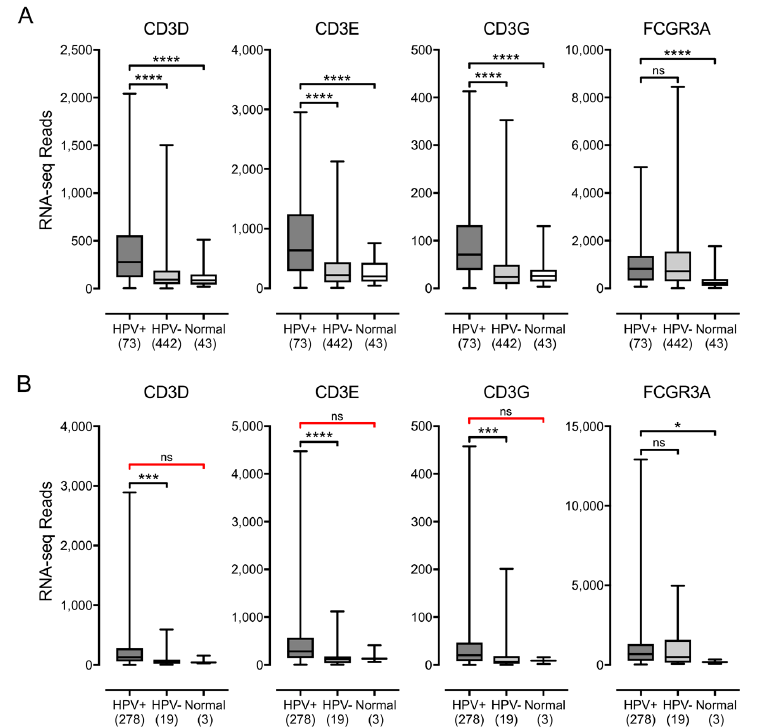
Figure 5. Detection of tumor infiltrating T-cells and NK-cells in head & neck and cervical carcinomas stratified by HPV status. Normalized RNA-seq data for genes indicative of tumor-infiltrating T cells (CD3D, CD3E and CD3G) or NK cells (FCGR3A) was extracted from the TCGA database for the HNSC ( A ) and CESC ( B ) cohorts for HPV+, HPV − , and normal control tissues. Numbers in brackets refer to the number of samples included in each analysis. * p ≤ 0.05; ** p ≤ 0.01; *** p ≤ 0.001; **** p ≤ 0.0001; ns—not significant; red brackets indicate a comparison that did not achieve significance with a power value <0.8.